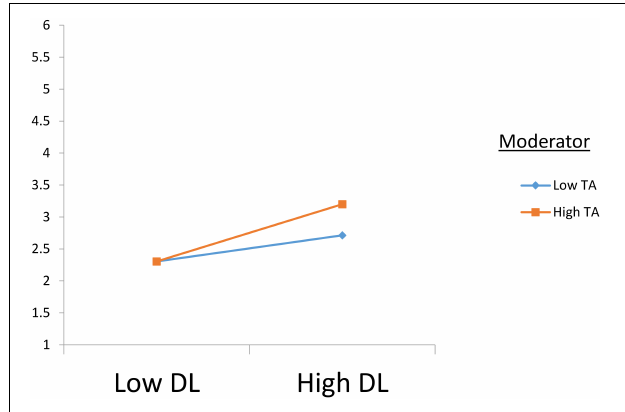
FIGURE 3 | Interaction plot for WFC. DL, Despotic Leadership; TA, Trait Anxiety; WFC, Work Family Conflict. N = 224.